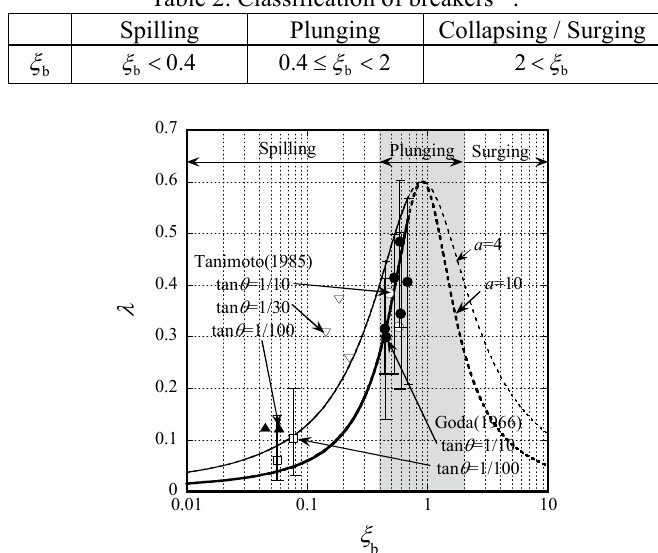
Relationship between surf similarity parameter ξ